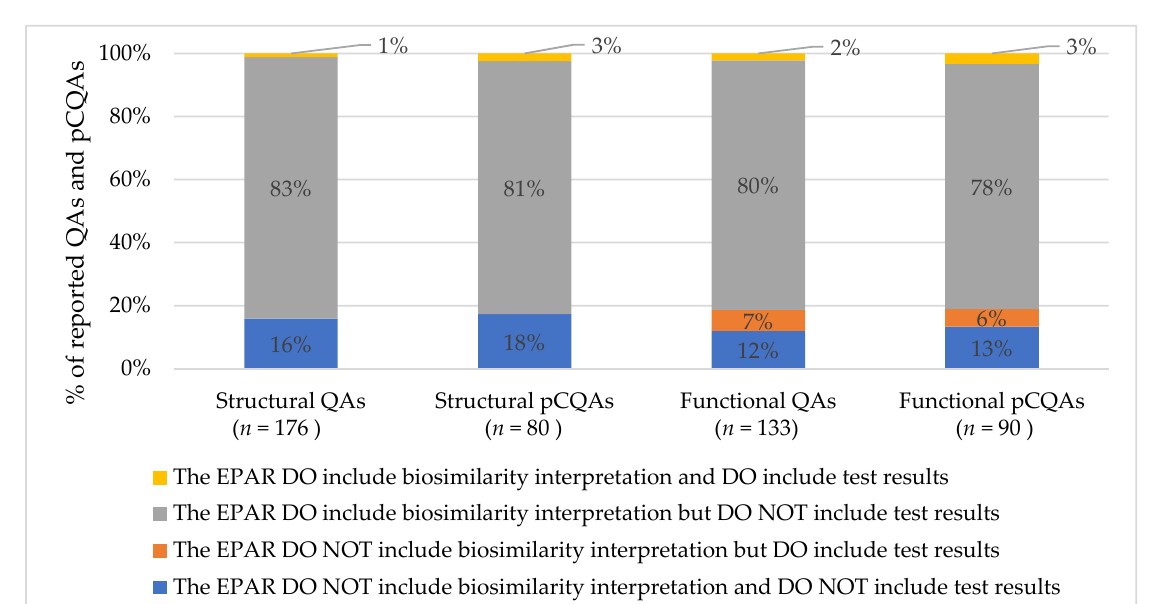
Figure 1. Comparison of the extent of reported information on quality attributes (QAs) and potentially critical quality attributes (pCQAs) stratified by the types of QAs and pCQAs (structural and functional) reported in all EPARs of adalimumab biosimilars included.